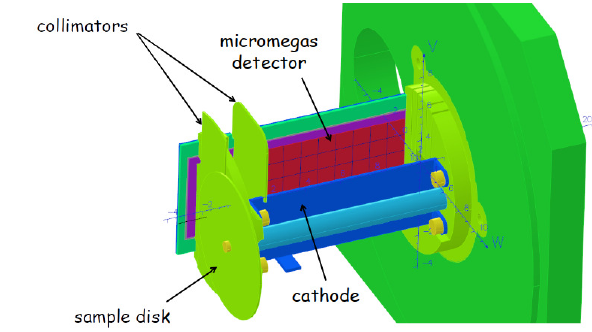
Figure 4. Detector geometry implemented in OPERA simulations.